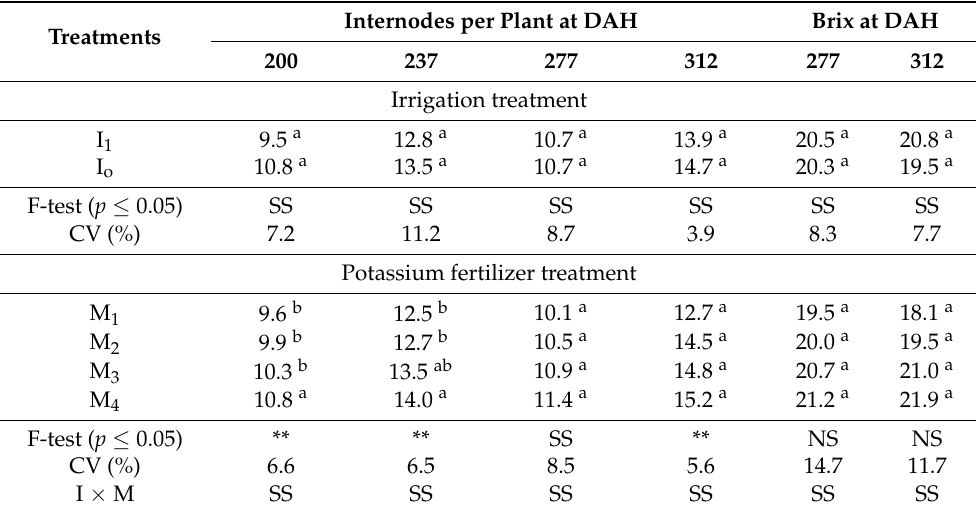
Table 3. Average number of internodes per plant and average Brix under irrigation and potassium treatments.